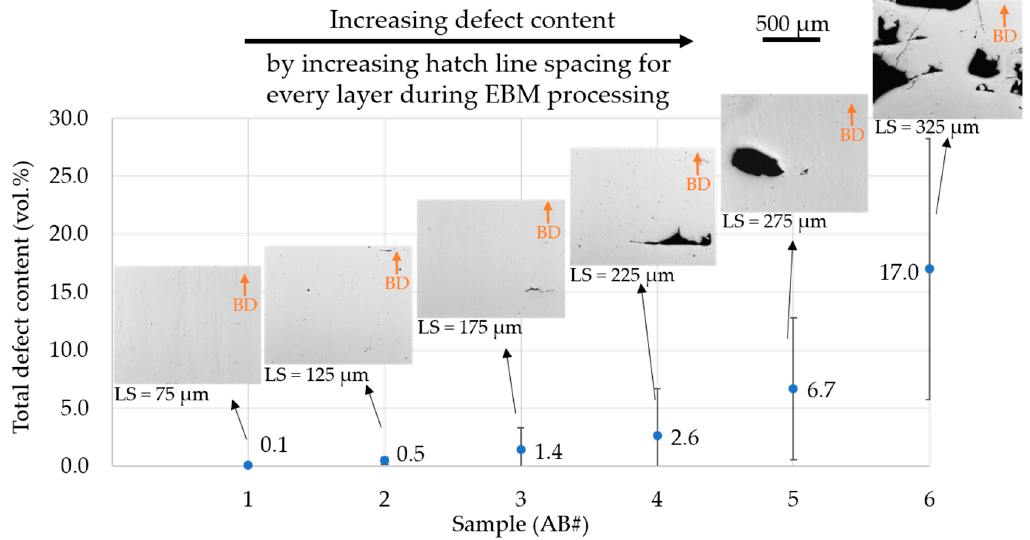
Figure 2. Defect content in as-built samples intentionally built with varied hatch line spacing (LS). The size and amount of defects are visualized in the insets. Arrows in the inset indicate build direction.